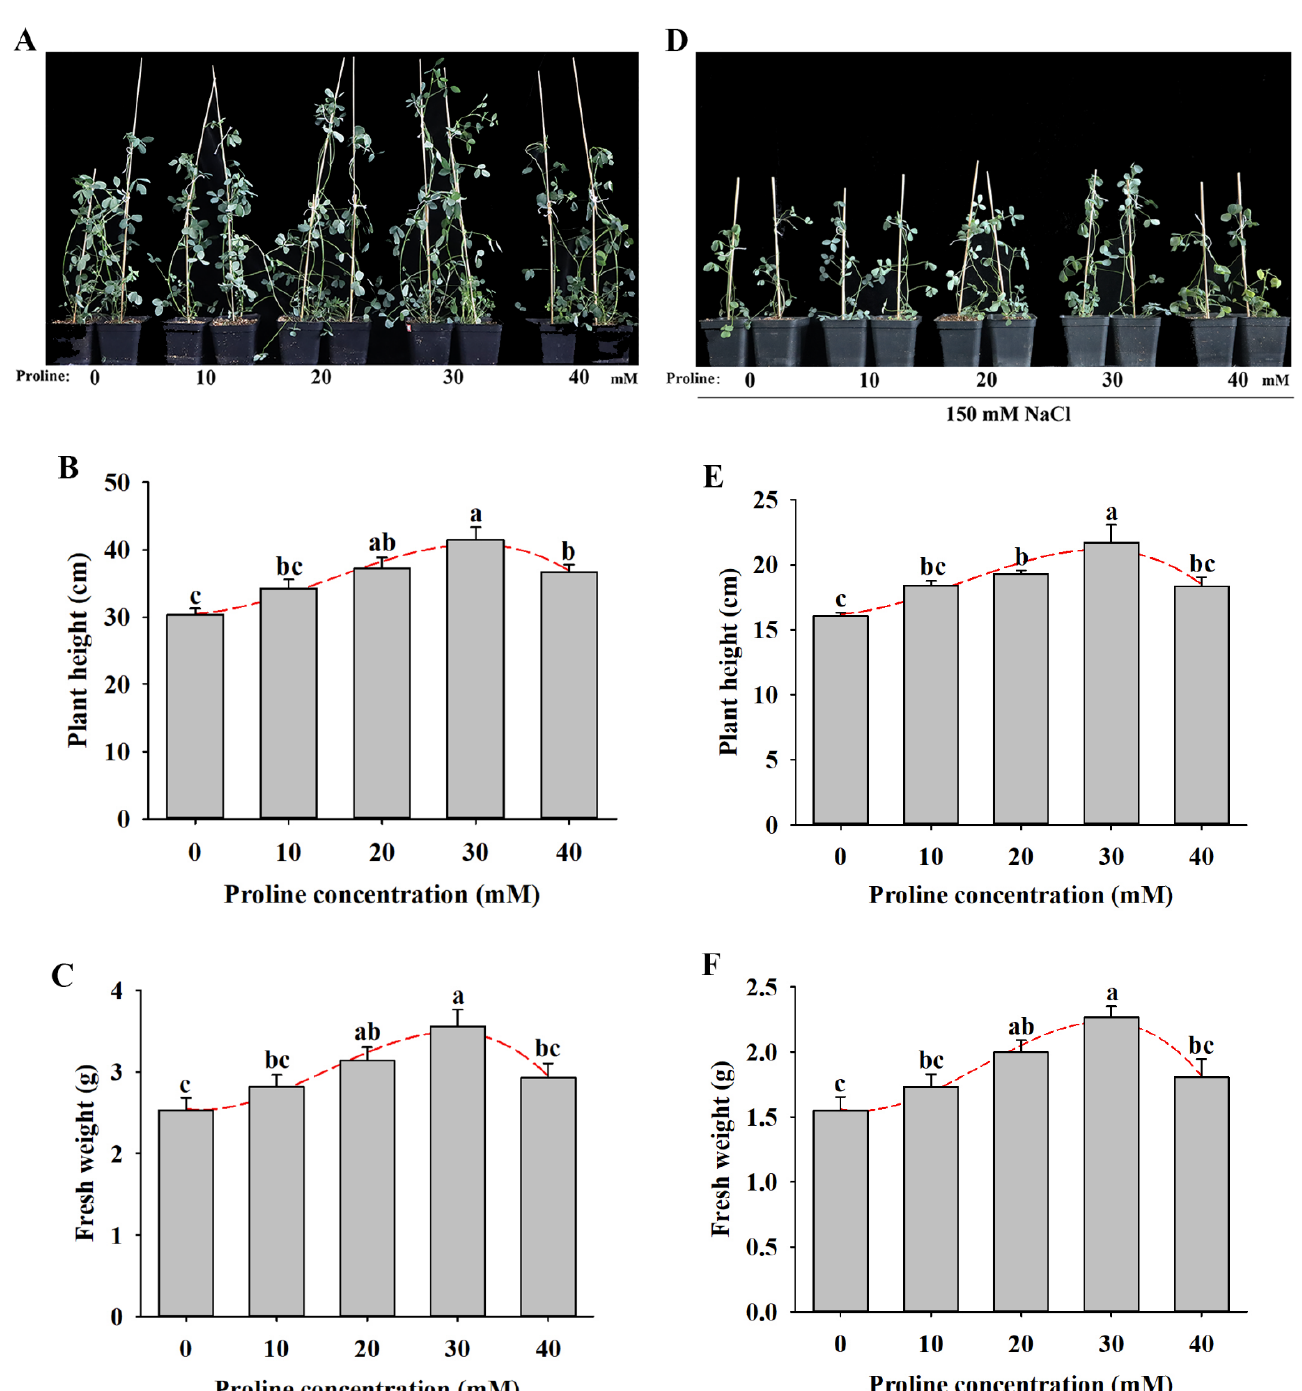
Figure 3. Effects of different concentrations of proline (0, 10, 20, 30, and 40 mM) treatment on soil- grown alfalfa plants under normal or salt stress conditions. ( A – C ) Phenotype of a representative individual from each treatment ( A ), plant height ( B ), and fresh weight ( C ) of alfalfa plants under normal conditions. ( D – F ) Phenotype of a representative individual from each treatment ( D ), plant height ( E ), and fresh weight ( F ) of alfalfa plants under salt stress conditions. Data are means ± SE ( n = 3), and different letters indicate significant differences between groups ( p < 0.05).